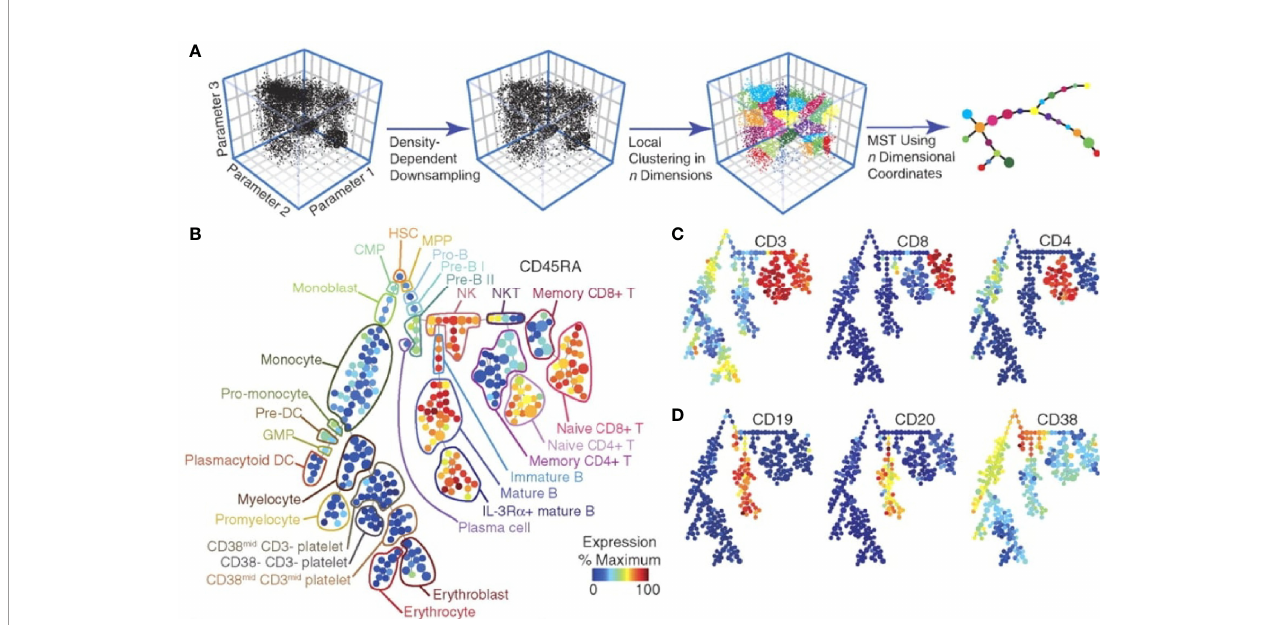
FIGURE 2 | SPADE analysis of multidimensional data. Overview of simplifying multi-dimensional data into a two-dimensional plot by SPADE analysis (A) . A tree plot constructed by SPADE software utilizing 13 cell surface markers identi fi ed hematopoietic cell populations (B) . Expression levels of speci fi c markers can be visualized for each cellular sub-population (C, D) . Figure adapted from Bendall et al. (4), with